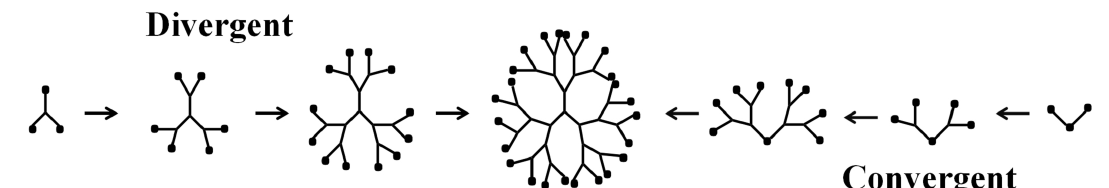
FIGURE 1 - Schematic showing the divergent versus convergent synthetic